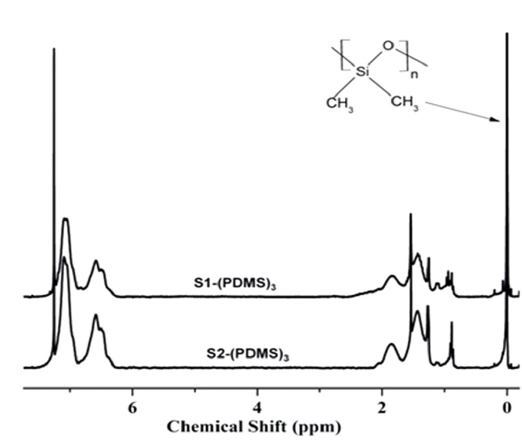
Fig 5. EDX spectrum for sample S2-(PDMS)